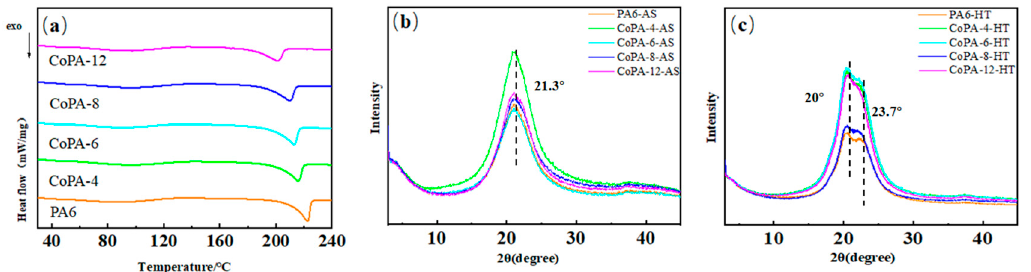
Figure 3. Thermal and crystallization performance analysis of PA6 and CoPAs from DSC ( a ) and Wide − angle X − ray diffraction scans for as − spun fibers ( b ) and high tenacity fibers ( c ).